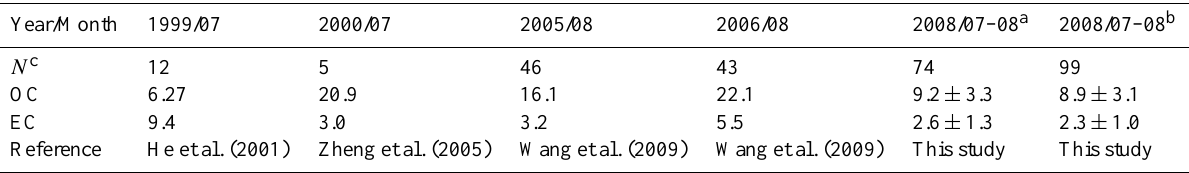
Fig. 1. PM 2 . 5 chemical composition at the PKU urban site and the upwind Yufa rural site. Data from 16 to 20 August for the PKU site are not available for technical reasons. Table 2. Concentration of organic carbon (OC) and elemental carbon (EC) in PM 2 . 5 (µgm − 3